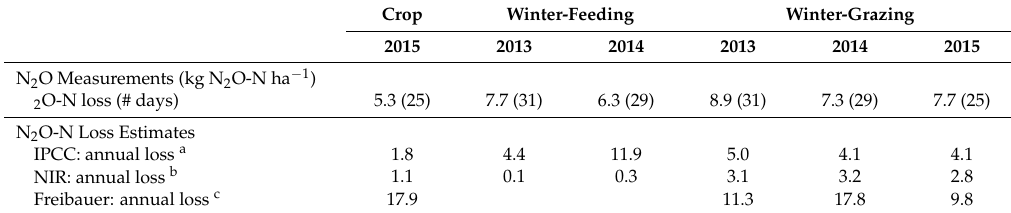
Table 2. Spring thaw N 2 O-N emission losses. Crop Winter-Feeding